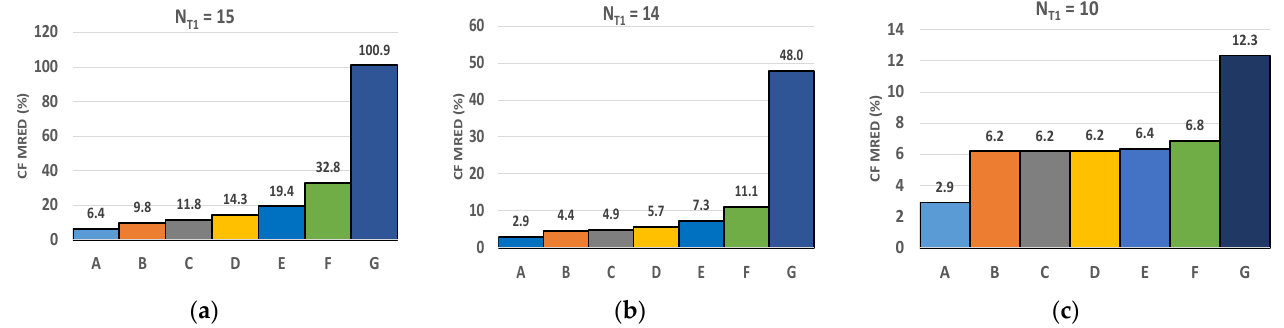
Figure 6. MRED (mean relative error distance) of CF dyn and CF static for a 7 × 7 convolution applied on the airplane bench- mark: ( a ) N T 1 = 15, ( b ) N T 1 = 14, ( c ) N T 1 = 10 . F = 4. A: Proposed approach with N T 2 = 0 and double computation on the same pixel to update CF dyn . B: Proposed approach with N T 2 = 0 and adopting simplifications (1) and (2). C: Same as B, with N T 2 = N T 1 − 2. D: Same as B, with N T 2 = N T 1 − 3. E: Same as B, with N T 2 = N T 1 − 4. F: Same as B, with N T 2 = N T 1 − 5. G: Conventional static correction with N T = N T 1 truncated columns.